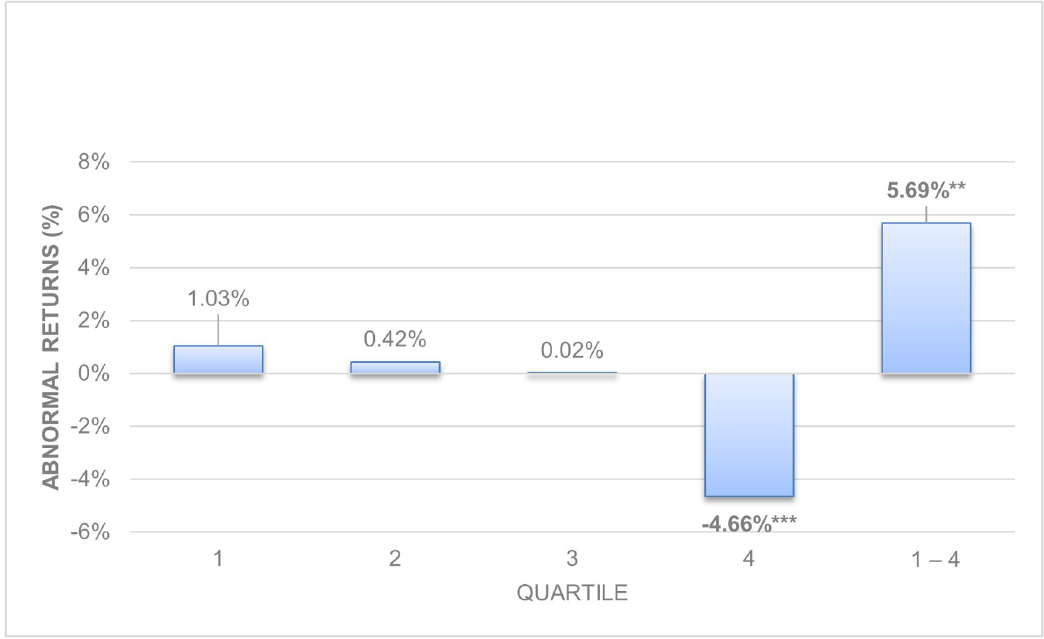
Fig 1. Size-adjusted abnormal returns. Long-term accruals.